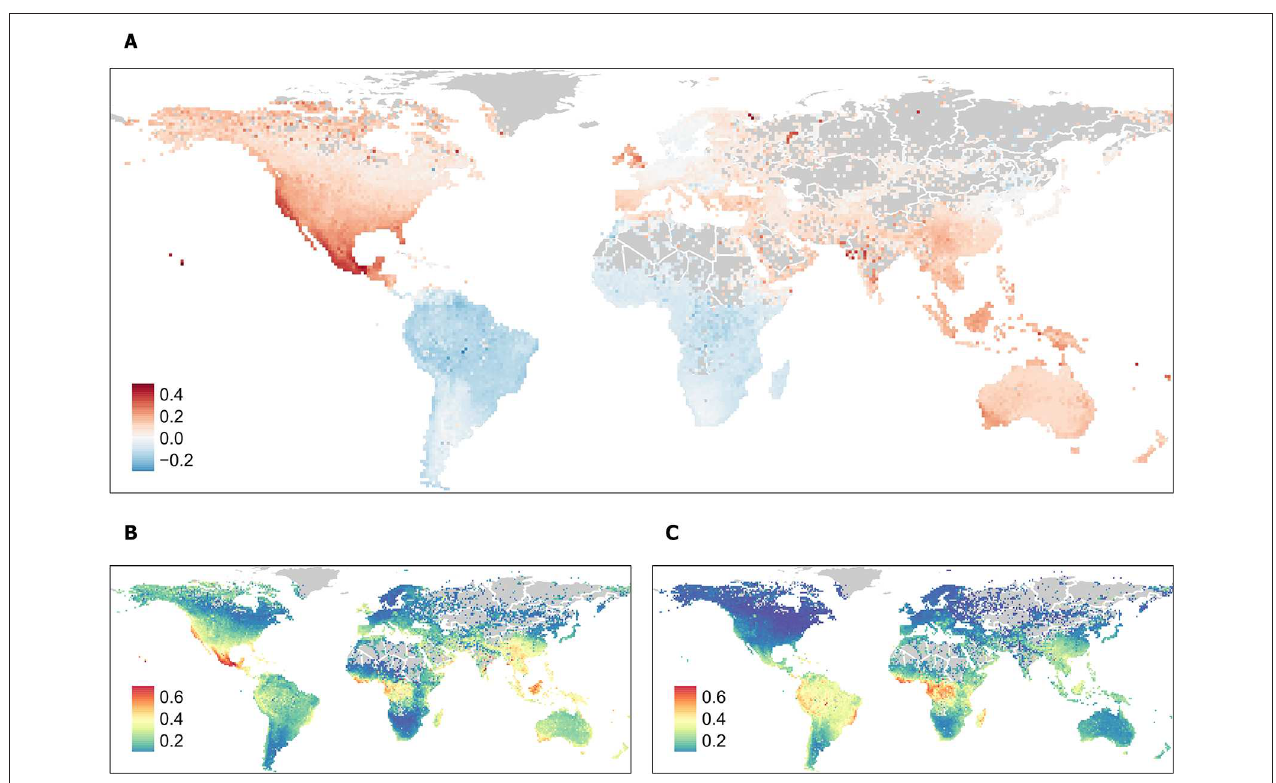
FIGURE 1 | (A) Difference in average per grid-cell probability of being threatened between (B) our reproduction of the continental predictions in Pelletier et al. and (C) predictions made from a single global model following the same protocol and using the same species. Map (A) highlights regions with potentially over-stated extinction risk (red), and potentially under-stated extinction risk